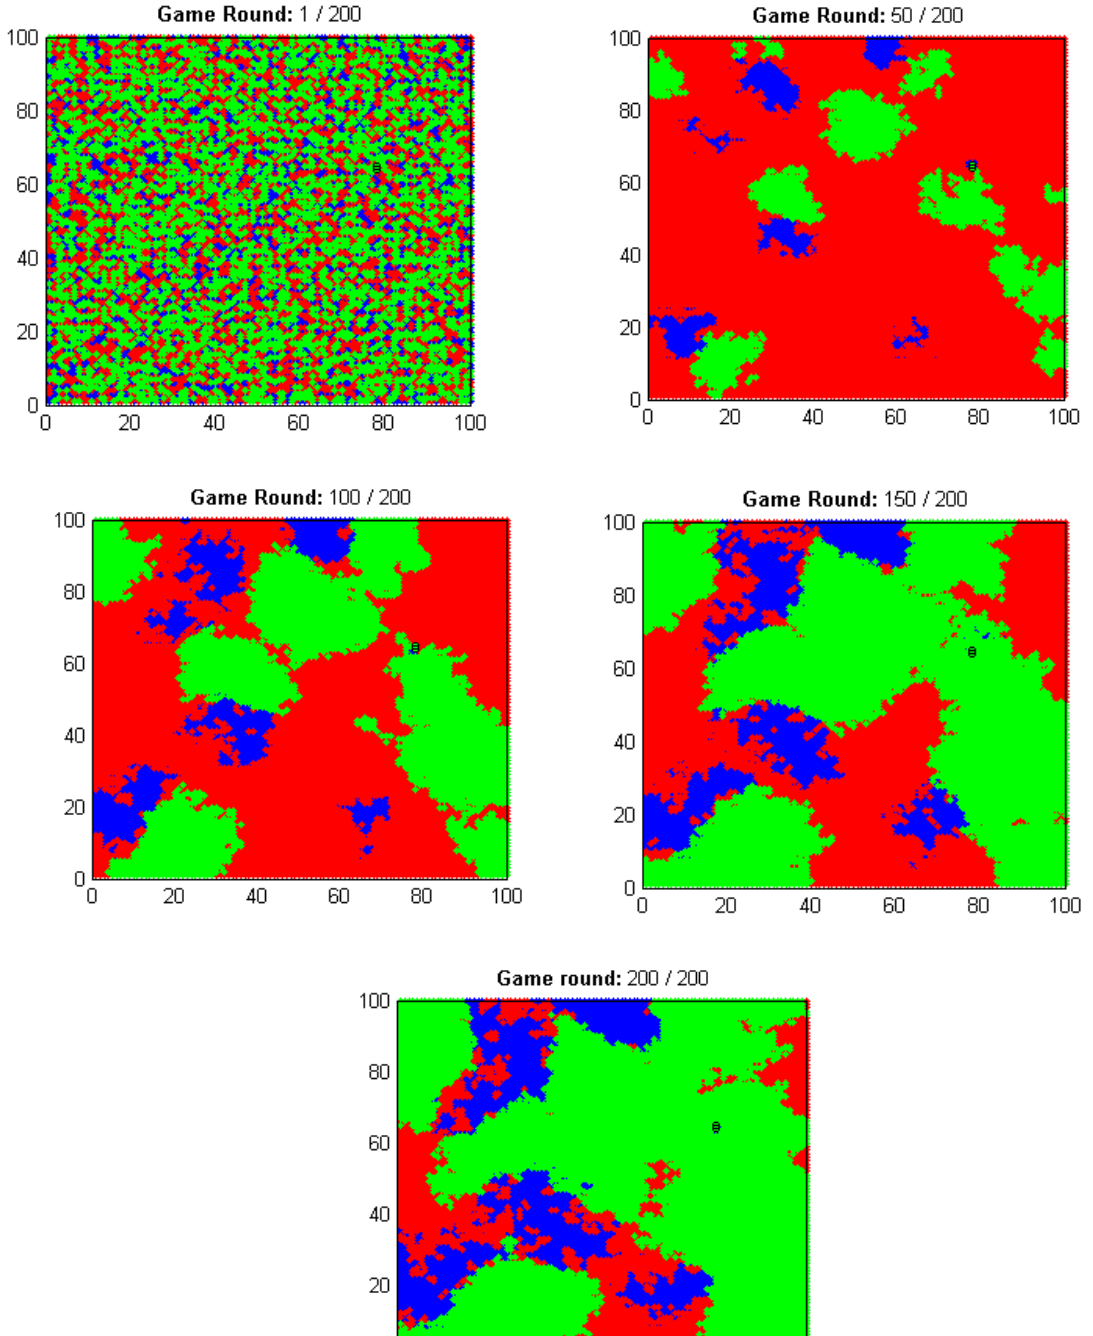
Figure 3. Simulation results for 200 rounds of the game. Red, green, and blue are assigned to the defector, reciprocator, and co-operator,